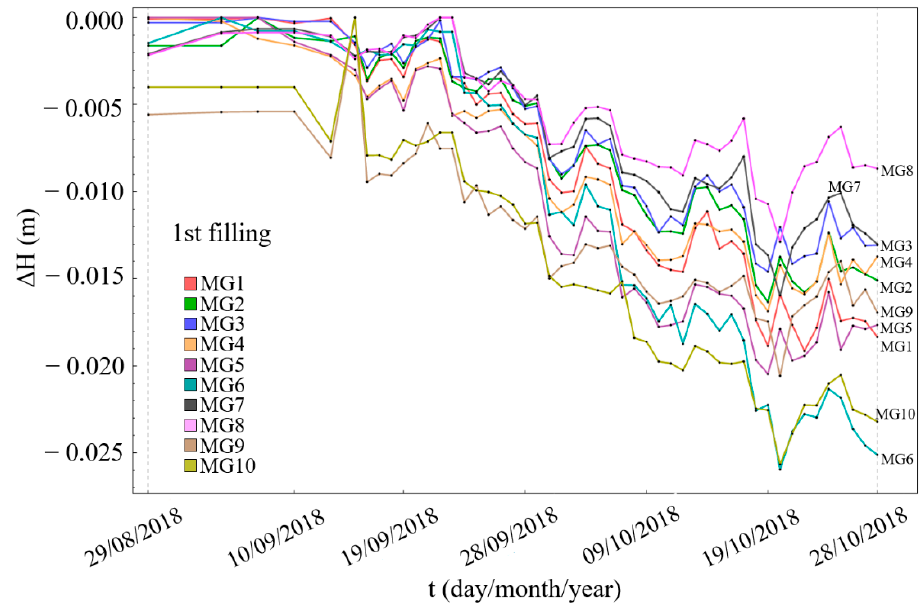
Figure 4. Settlement visualization of points MG1 to M10, from 29/08/2018 to 28/10/2018.